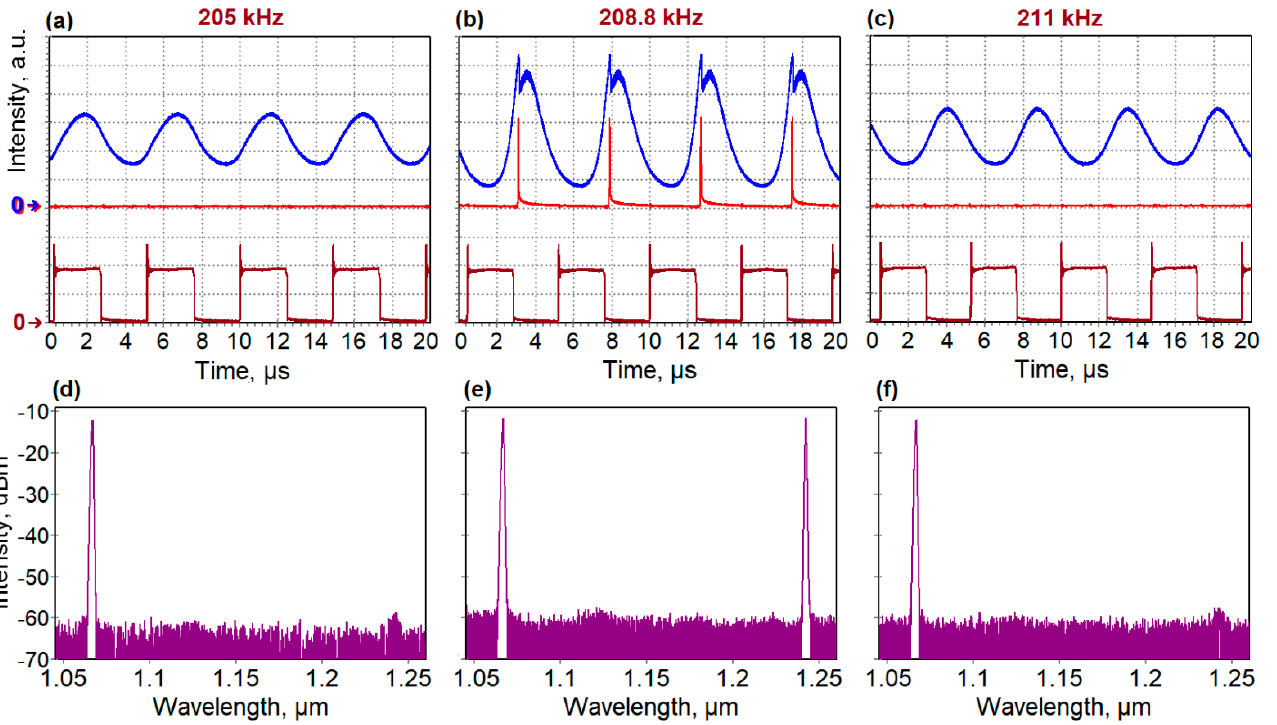
Figure 5. Temporal ( a – c ) and spectral ( d – f ) traces acquired at different modulation frequencies selected within and beyond the Raman power resonance shown in Figure 4. The legends of the oscillograms ( a – c ): blue traces—the fundamental radiation at 1.07 µ m; red traces—the Stokes radiation at 1.24 µ m; and brown traces—the pump radiation at 0.98 µ m.